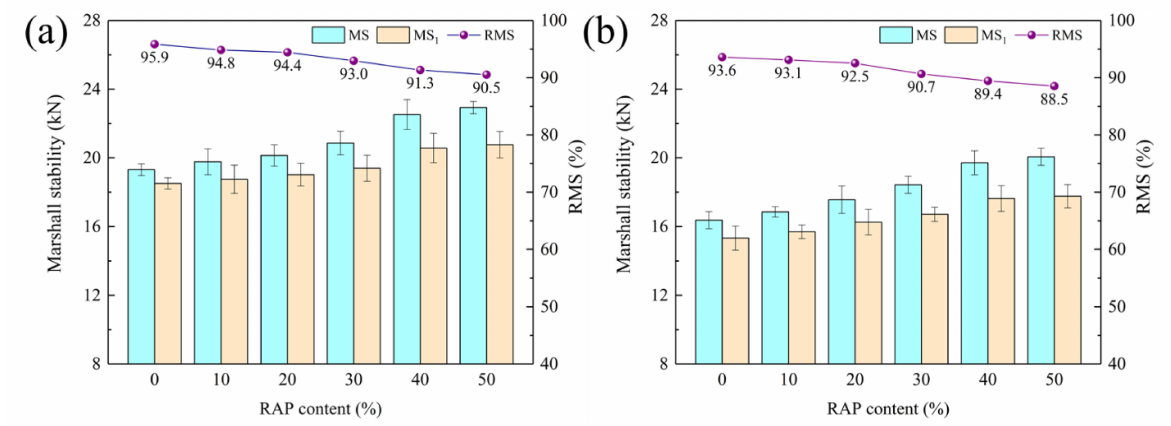
Figure 4. RMS results of RAM: ( a ) steel slag; ( b )